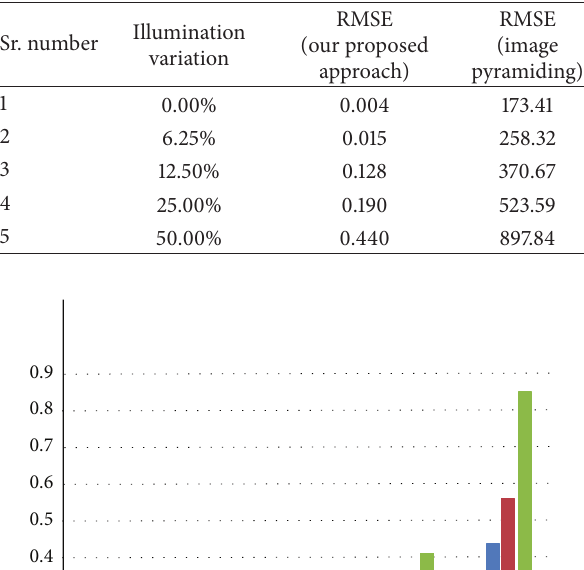
Table1:RMSEforvariousilluminationvariations(inputstereopair: tsukuba).